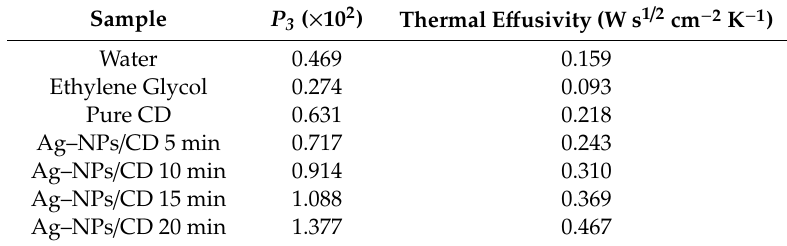
Table 2. The thermal e ff usivity of the adjustment parameter ( P 3 ) of Ag–NPs / CD composite